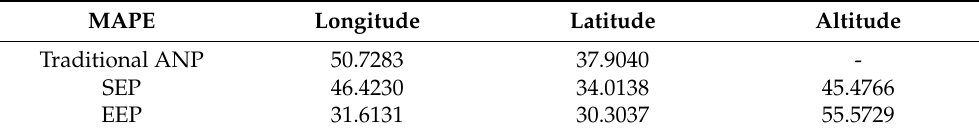
Monte Carlo simulation. Monte Carlo